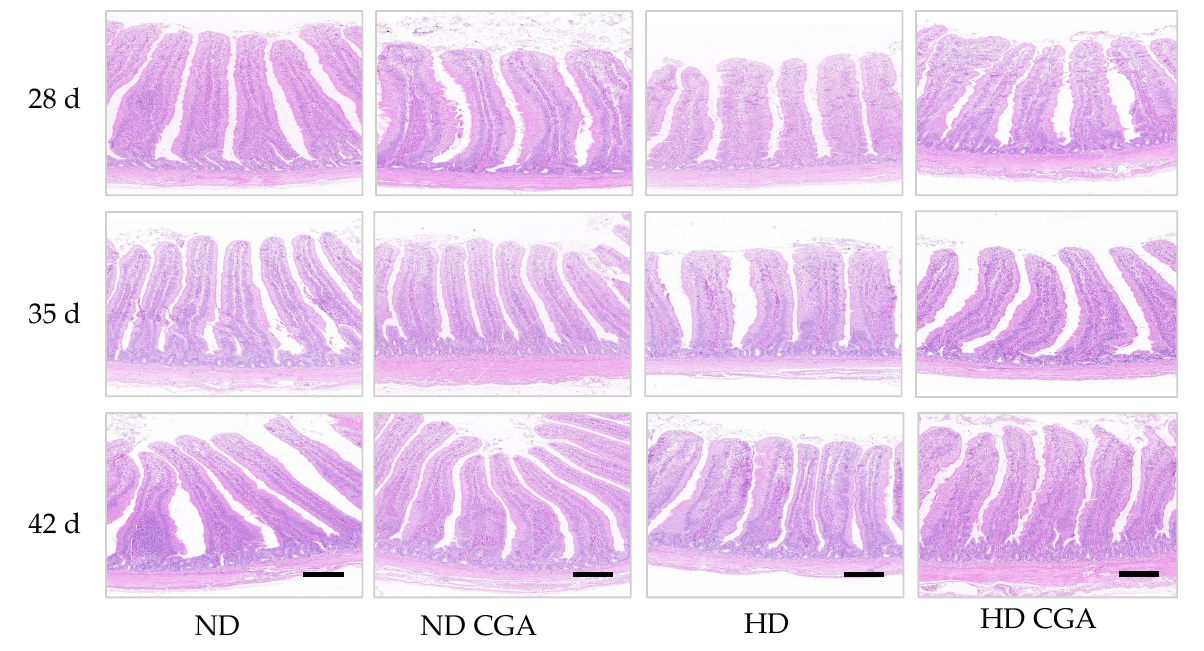
Figure 2. Effects of CGA on jejunal morphology of broilers under HD stress. ND group, normal stocking density + basal diet; ND + CGA group, normal stocking density + basal diet + 0.15% CGA; HD group, high stocking density + basal diet; HD + CGA group, high stocking density + basal diet + 0.15% CGA. Scale bar = 100 µm.